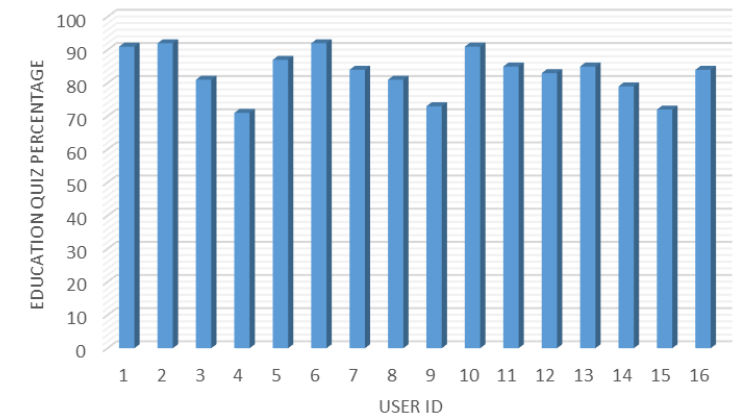
Figure 11. Education quiz percentage for the 16